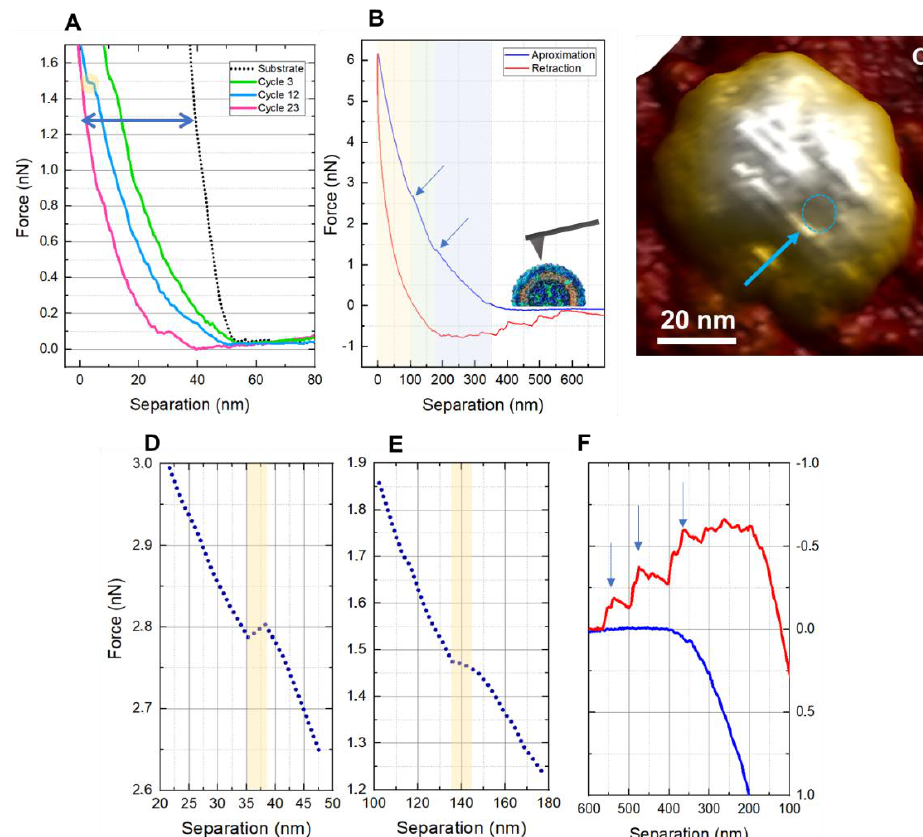
Figure 4. Zika viral particle indentation curves. ( A ) reference curve obtained during the cycles of approach and retraction, demonstrating that as the cycles increase, the curve also tends to lengthen. ( B ) Graph of the Force vs. Separation effected by a single stimulus (cycle) shows that the blue trace represents the approach curve, while the red indicates the retraction curve. The yellow, green, and blue tracks relate to the viral particle’s three different types of materials. The blue arrows in detail of the contact ramp on the approach curve highlight the rupture plateau. ( C ) The image in the inset represents the ruptured region of the structure of the virus membrane, where the blue circle suggests a hole formed by the proteins of the outer layer. ( D , E ), related to the shell breakage, represented by the yellow band. ( F ) Tethering events (blue arrows) are observed in the retraction curve (red), matching that ZIKV has only its outermost layer of protein.